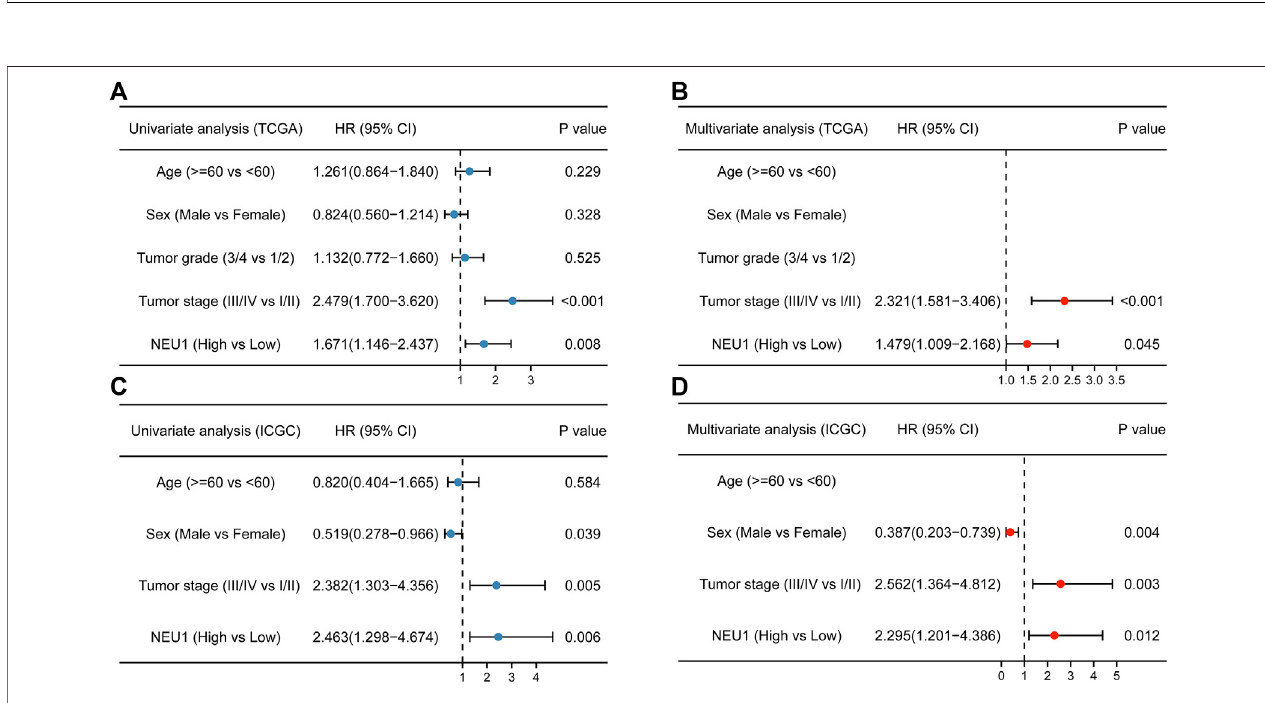
FIGURE 5 | Results of univariate and multivariate Cox analyses of clinical factors and NEU1 expression (A) Forest plot of univariate analysis in TCGA cohort (B) Forest plot of multivariate analysis in TCGA cohort (C) Forest plot of univariate analysis in ICGC cohort (D) Forest plot of multivariate analysis in ICGC cohort.